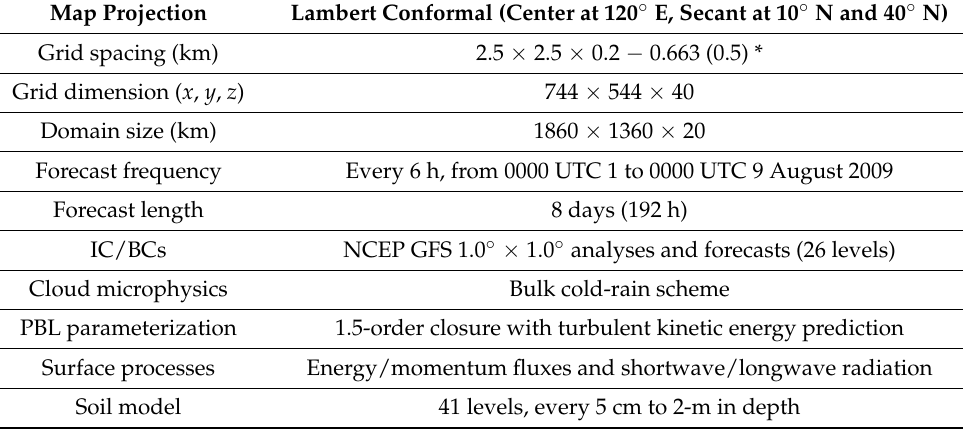
Table 1. The basic domain configuration and physical packages of the 2.5-km CReSS in this study. Map Projection